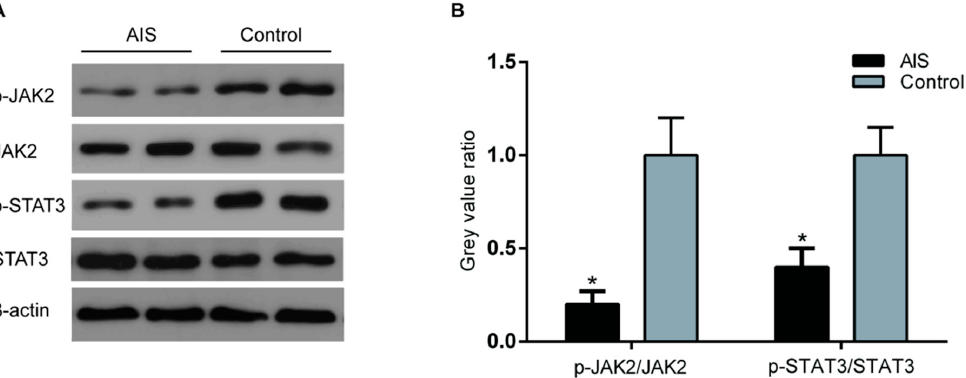
Figure 3. JAK2 and STAT3 phosphorylation status in the AIS and the control groups. ( A ) Protein samples were acquired from the cartilage tissue of the participants in both the AIS and the control groups. The expression of p-JAK2, total JAK2, p-STAT3, and total STAT3 was analyzed by Western blotting. β -actin was used as an internal reference. Representative Western blots from three independent experiments are shown; ( B ) Relative quantitation of the p-JAK2/JAK2 and axis represents the fold change between the AIS and control groups. * p < 0.05 vs. the